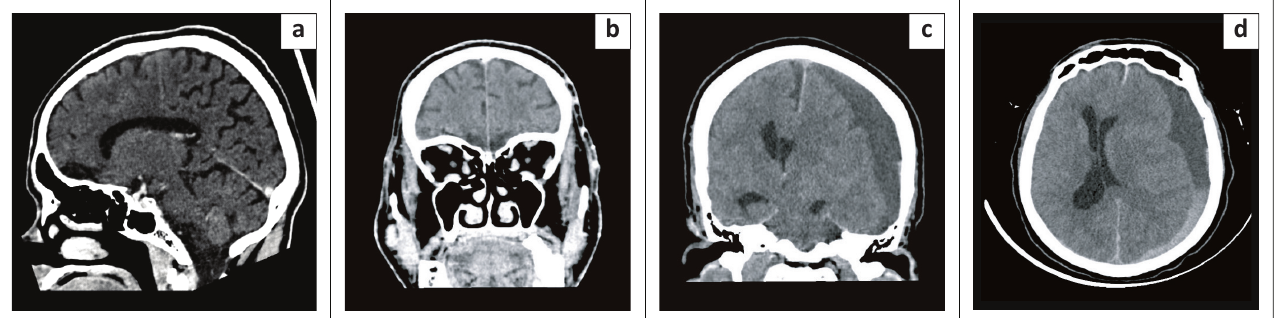
FIGURE 4 : Trauma related pathology as a cause of adult-onset seizures. (a and b) Bilateral rectus gyri gliosis in a 49-year-old male with new-onset seizures. Sagittal and coronal contrast enhanced CT (CECT): Hypodensities of bilateral rectus gyri consistent with gliosis. (c and d) Left acute subdural hematoma in a 72-year-old male with new-onset seizures and confusion. Axial and coronal non-enhanced CT (NECT): Large left mixed density subdural hematoma with a haematocrit level. Associated subfalcine and uncal herniation with right lateral ventricle entrapment hydrocephalus.